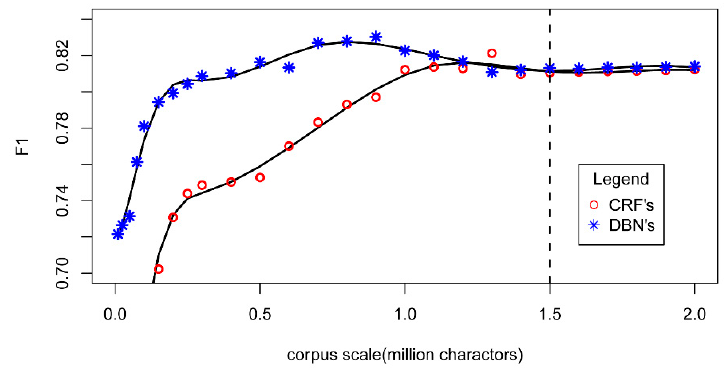
Figure 12. The F1 trends of CRF and DBN on different corpus sizes.